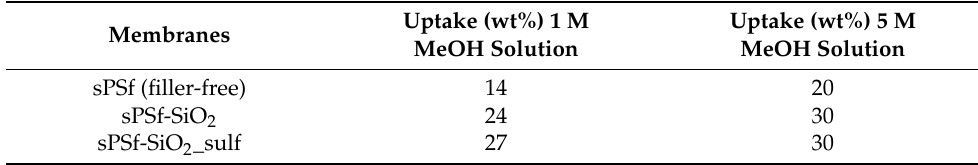
Table 1. Aqueous methanol solution uptakes (wt%) of the membranes at 20 ◦ C.